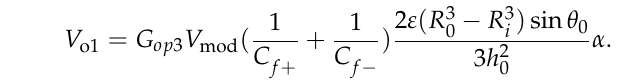
Figure 9. Signal processing system: ( a ) signal detection part; ( b ) signal filtering part.